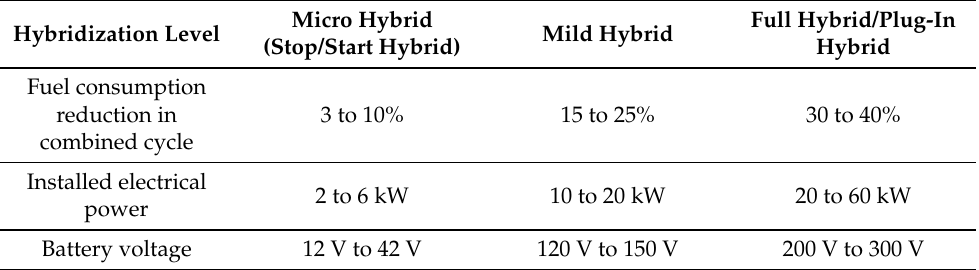
Table 3. Hybrid vehicles: level of